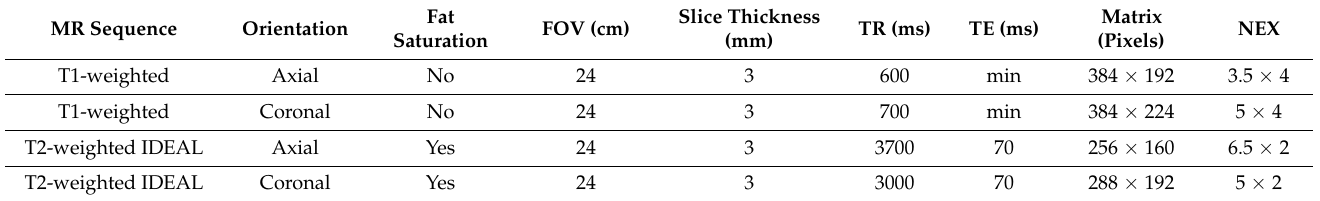
Table 1. Acquisition parameters used in this study for various magnetic resonance neurography (MRN)